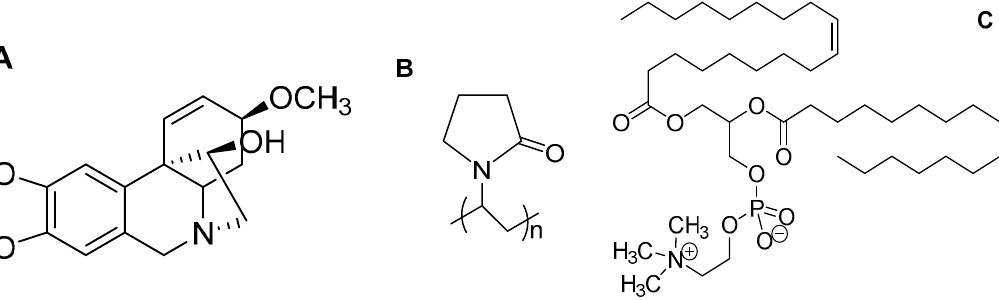
Figure 1. The chemical structure of ( A ) haemanthamine (HAE), ( B ) polyvinylpyrrolidone (PVP) and ( C ) phosphatidylcholine (PC).